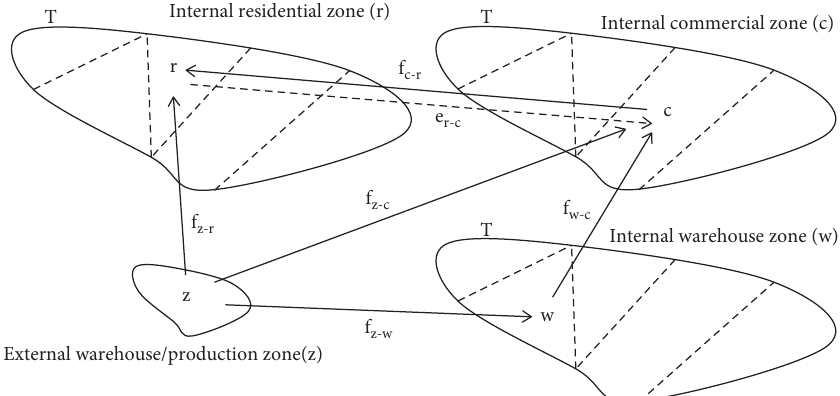
Figure 1: Zones, freight flows, and passenger flows relationships between zones of the study